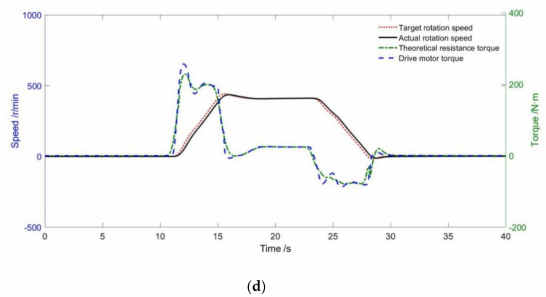
Figure 12. Simulation results of test-beds with di ff erent inertia: ( a )with the penalty function when the inertia is 0.5 kg · m 2 ; ( b )without the penalty when the inertia is 0.5 kg · m 2 ; ( c )without the penalty function when the inertia is 0.1 kg · m 2 ; ( d ) without the penalty function when the inertia is 5 kg · m 2 .